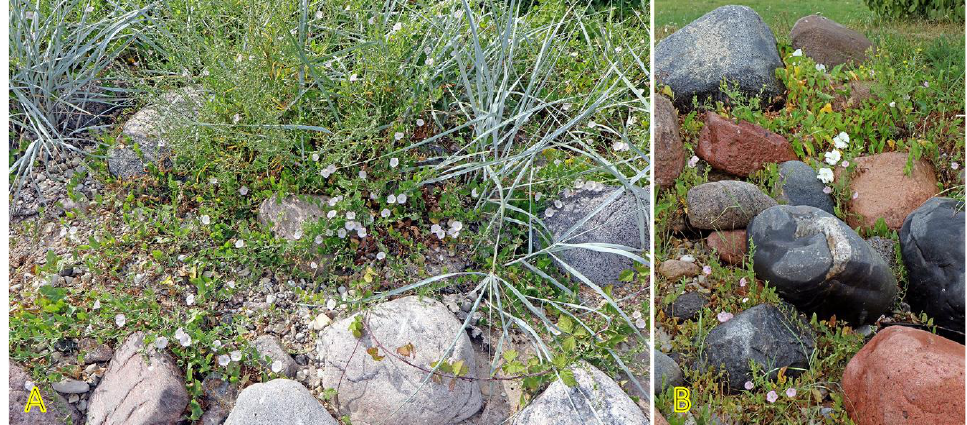
Figure 10. Convolvulus arvensis on a stony beach together with Leymus arenarius on the island of Kihnu, Estonia ( A ), on a stony beach together with Calystegia sepium on the island of Saaremaa, Estonia ( B ).